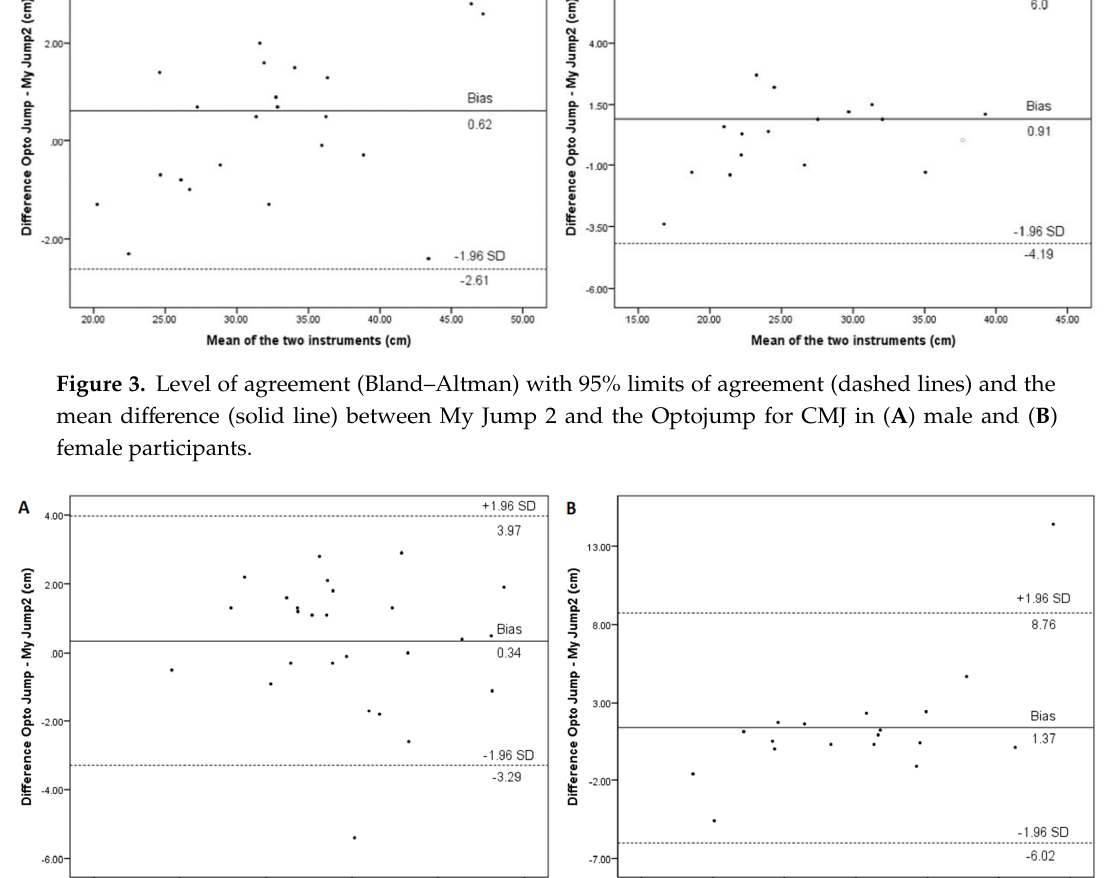
Figure 4. Level of agreement (Bland–Altman) with 95% limits of agreement (dashed lines) and the mean difference (solid line) between My Jump 2 and the Optojump for CMJAS in ( A ) male and ( B ) female participants.